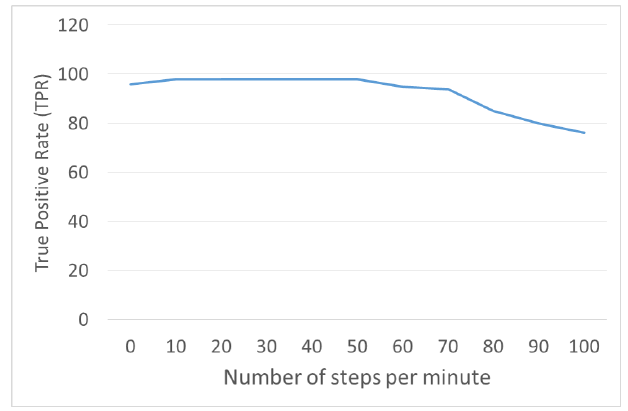
Figure 11. Direction of motion of human being during experiment